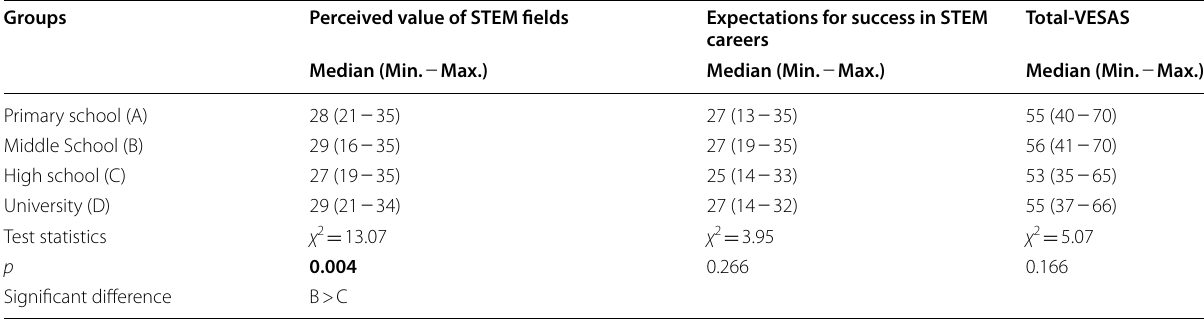
Table 5 The results of Kruskal − Wallis test for participants’ STEM motivation scores according to their mothers’ educational levels Groups